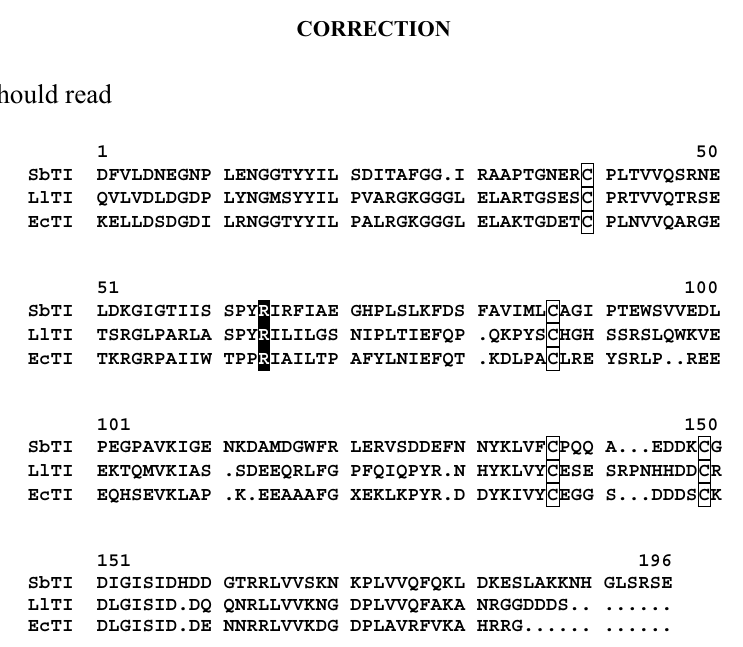
Fig. 1 – Comparative sequences of related Kunitz inhibitors SBTI (soybean trypsin inhibitor); LlTI – Leucaena leucocephala (Oliva et al. 2000) and EcTI – Enterolobium contortisiliquum (Batista et al. 1996). SBTI identical residues are in the gray; the cysteine residues are indicated by black boxes. The P 1 residues of the reactive sites are in the black